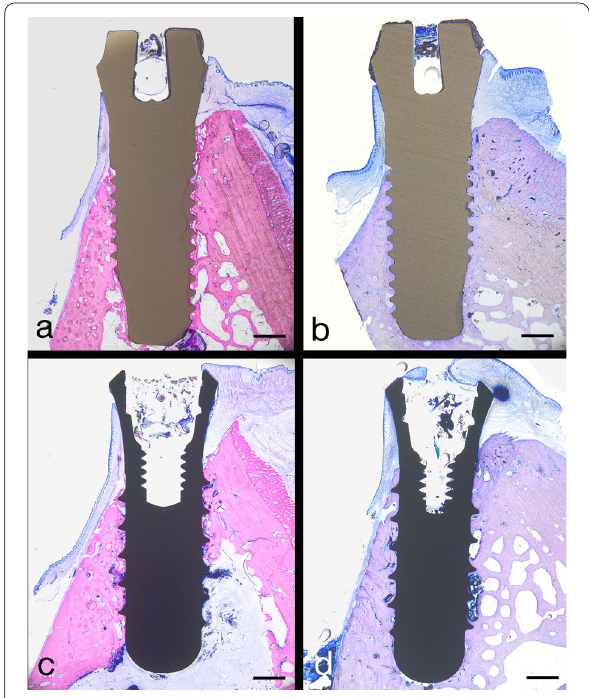
Fig. 3 Light microscopic (LM) micrographs showing representative overviews of longitudinal sections through YTZP implants following 4 weeks ( a ) and 8 weeks ( b ). Overviews of Ti-SLA implants are given in ( c , following 4 weeks) and (d, following 8 weeks). Scale bars: 1